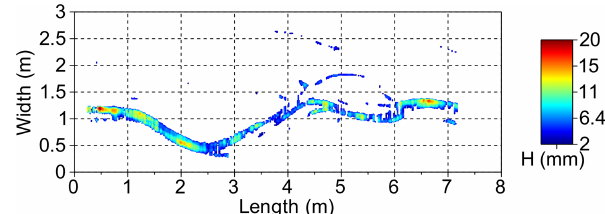
Figure 7. Example of a water depth map for a small (8m) reach of the